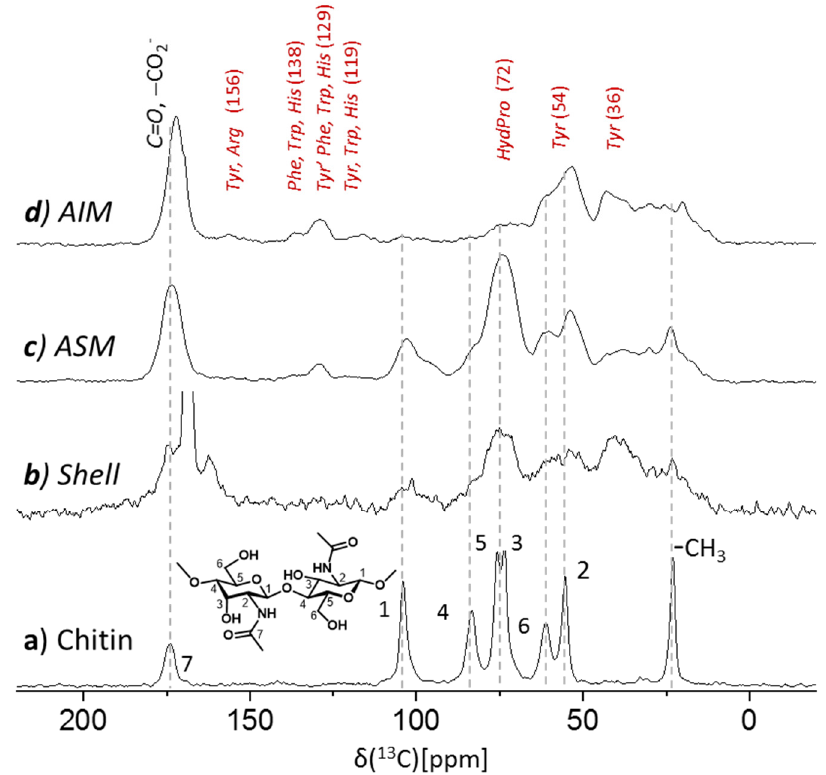
Figure 5. 75.4 MHz 13 C CPMAS spectra of ( a ) of α -chitin standard (shrimp), ( b ) the cleaned shell of Argonauta hians (vertically extended), and of its extracts ( c ) acid soluble and ( d ) acid insoluble matrices (AIM1 and ASM1). AIM of A. hians shells is primarily proteinaceous content while (oligo)saccharides (characteristic shifts of chitin indicated by the dashed line), if present, comprise less than a 10% fraction. ASM exhibits a pronounced oligosaccharide(s) content and less pronounced proteinaceous content.